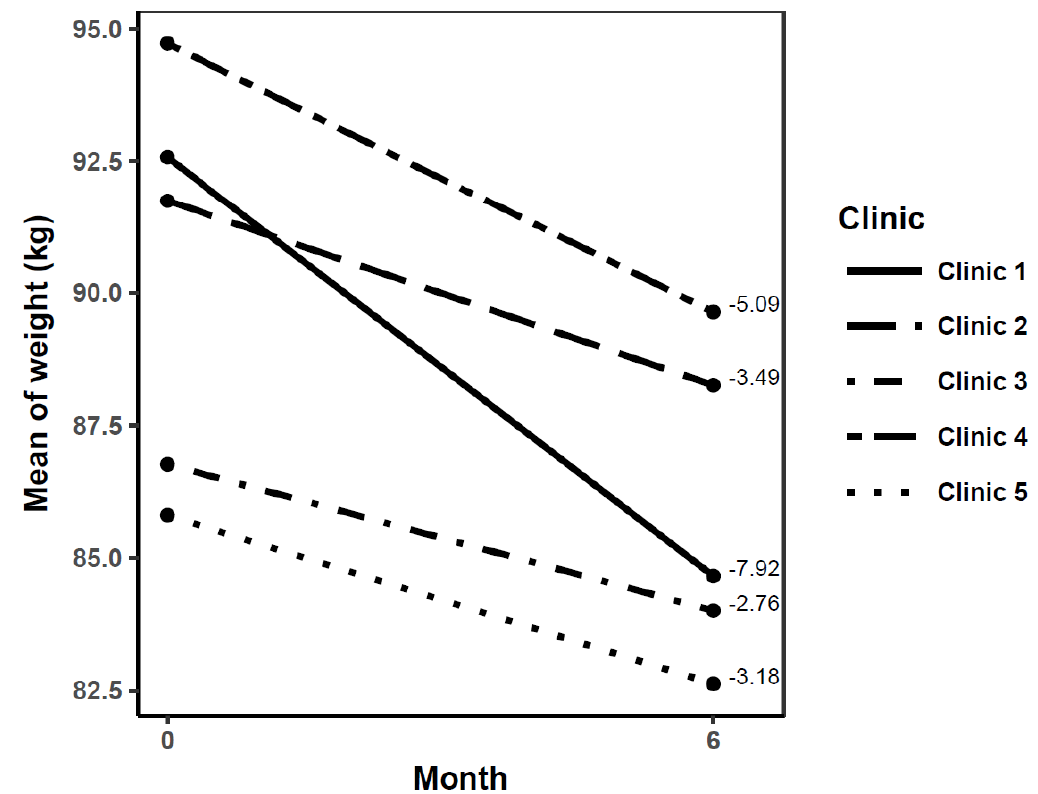
Figure 2. Change in body weight of participants who completed the 6-month phase of lifestyle intervention per clinic. Change in body weight (mean ± SD, 95% CI) in each clinic: 1 (−7.92 ± 6.84 kg, 95% CI −10.3, −5.57), 2 (−3.49 ± 4.12 kg, 95% CI −5.20, −1.79), 3 (−2.76 ± 4.76 kg, 95% CI −4.92, −0.60), 4 (−5.09 ± 5.03 kg, 95% CI −7.16, −3.00), and 5 (−3.18 ± 3.91 kg, 95% CI −4.73, −1.63). Table 3. Changes in obesity and blood pressure parameters of participants completing the 6 month intervention phase with the adapted Diabetes Prevention Program ( n = 133).